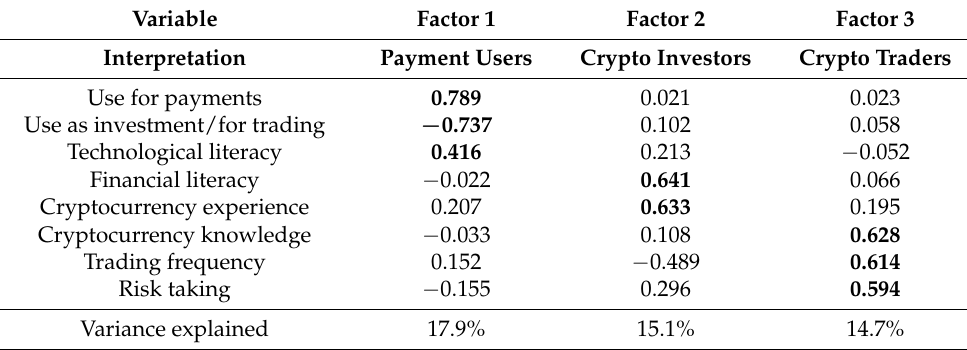
Table 2. Factor analysis of motives and characteristics of owning